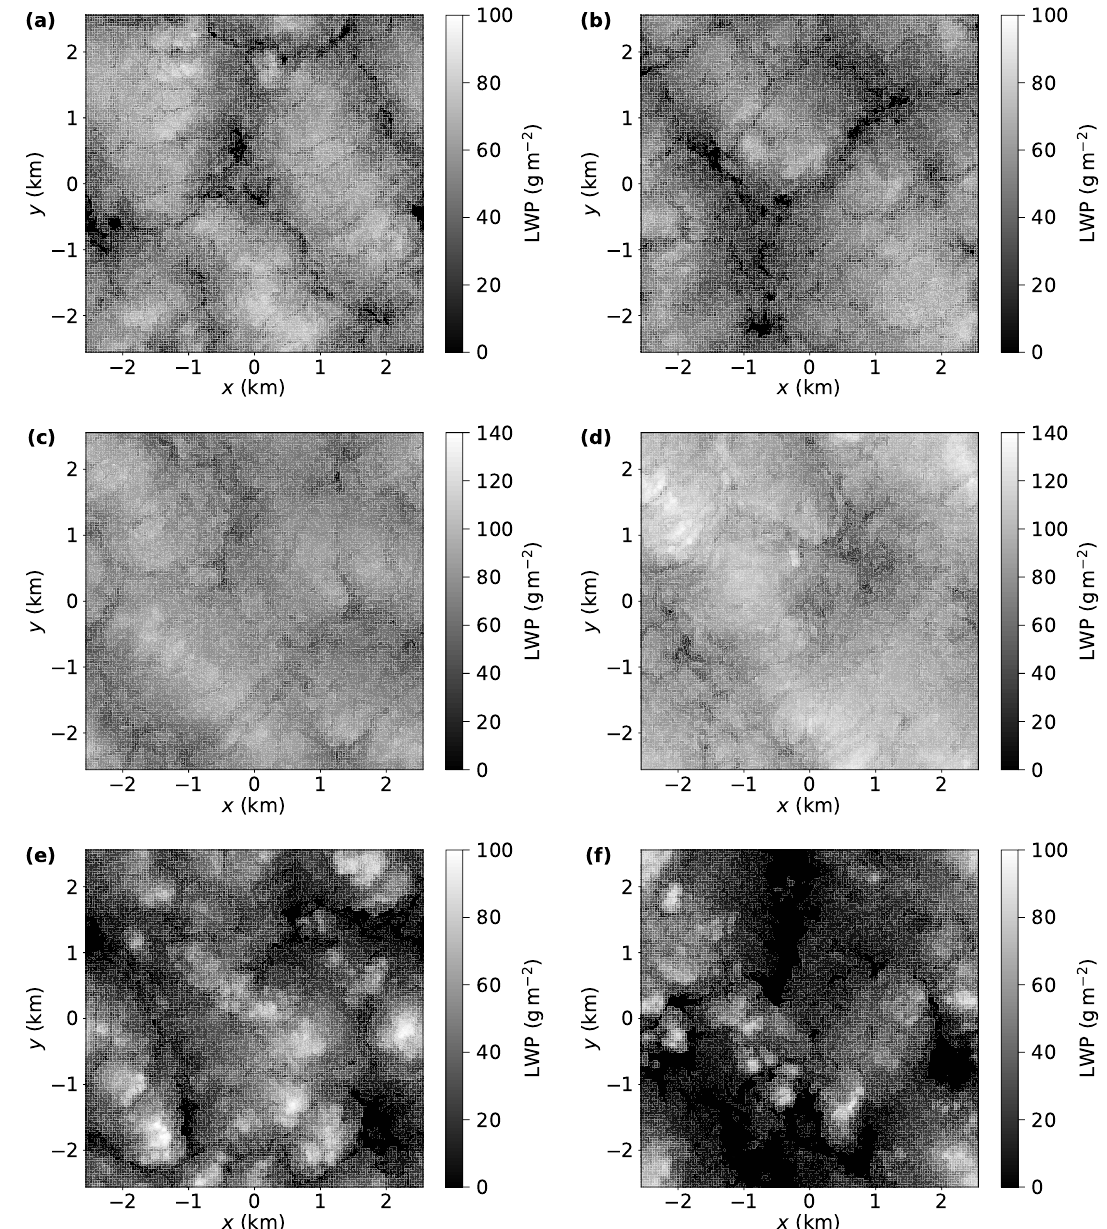
Figure 2. Liquid water path for the run with full physics, Case A3 ( a , b ), run without evaporative cooling, Case C3 ( c , d ), and the run without radiation, Case B3 ( e , f ). Left column panels ( a , c , e ) correspond to t = 2 h and right column panels ( b , d , f ) to t = 4